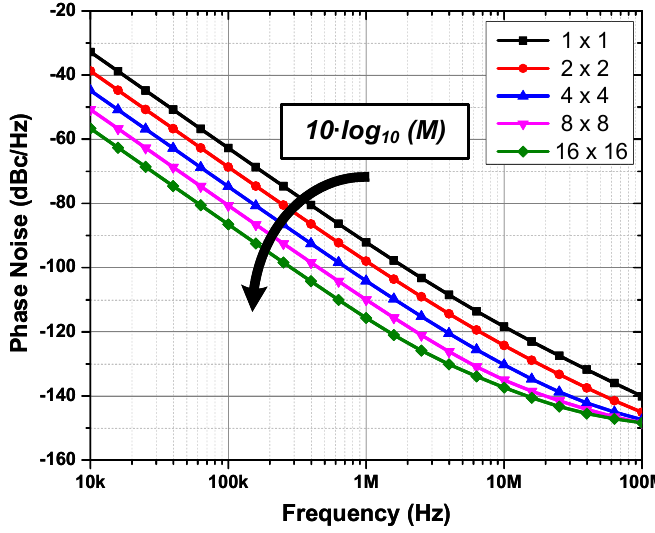
Figure 11. Simulation of phase noise reduction from 1 (1 × 1) to 256 (16 × 16) mutually-coupled